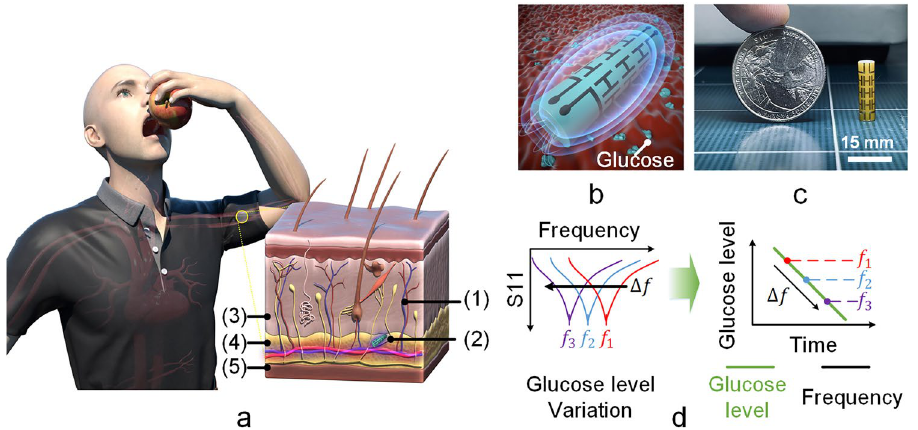
Figure 1. EM-based subcutaneous implant glucose sensor. ( a) Illustration of EM-based implantable sensor for BGL tracking; (1) blood capillary (2) electromagnetic sensor (3) dermis (4) subcutaneous fat (5) muscle tissue. ( b) Proposed implant sensor. ( c) Sensor size (15 mm × 4 mm ∅ ) compared with a coin. ( d) Sensor frequency trend and corresponding variations in